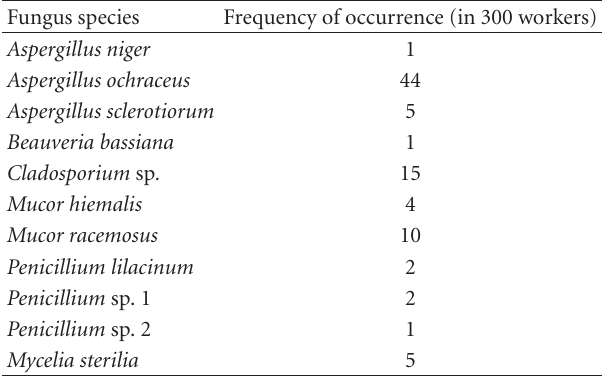
Figure 1: Cumulative time-related survival proportion (Kaplan- Meier curves) of the Atta bisphaerica forage worker ants from three di ff erent colonies. Table 1: Species and frequencies of the fungi isolated from 300 foragers of Atta bisphaerica.